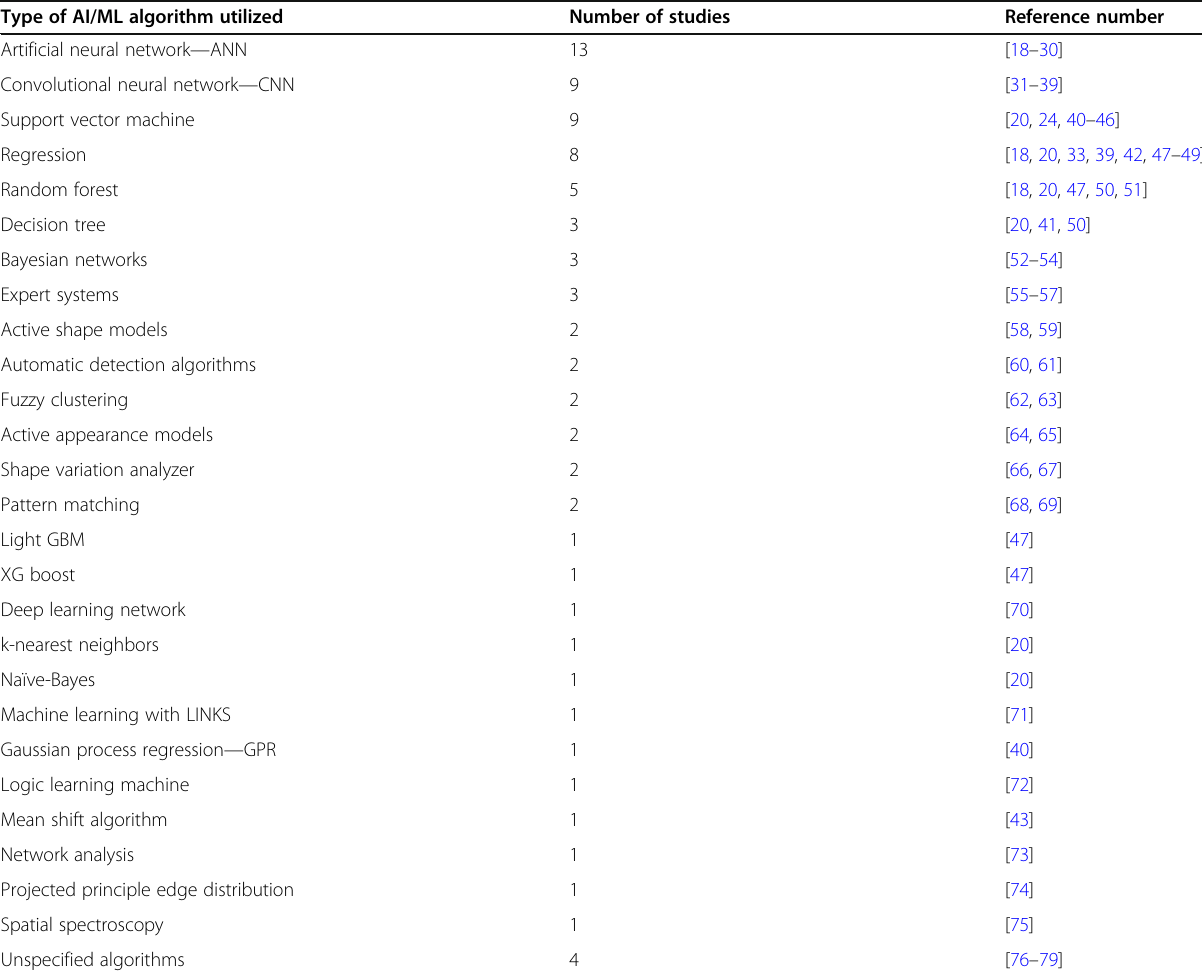
Table 3 Studies classified by AI/ML algorithm employed Type of AI/ML algorithm